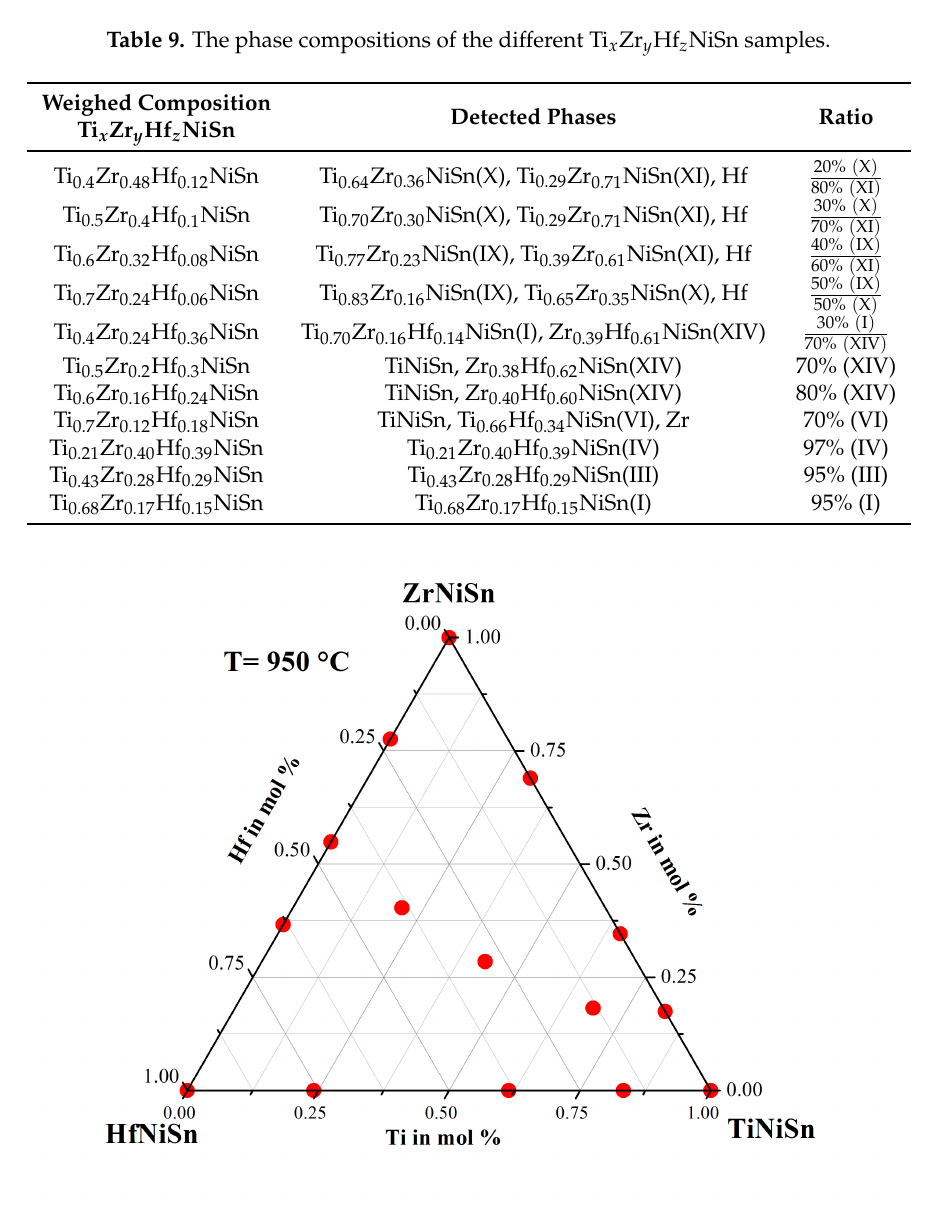
Figure 13. The detected stable phases at 950 ◦ C indicated in the Gibbs